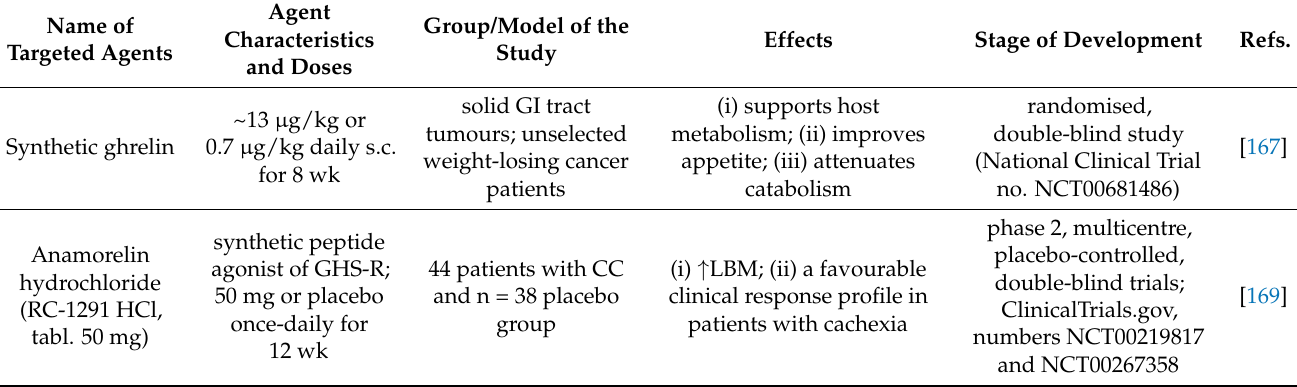
Table 4. Therapeutic Options Based on the Ghrelin System in Colorectal cancer (CRC)-associated